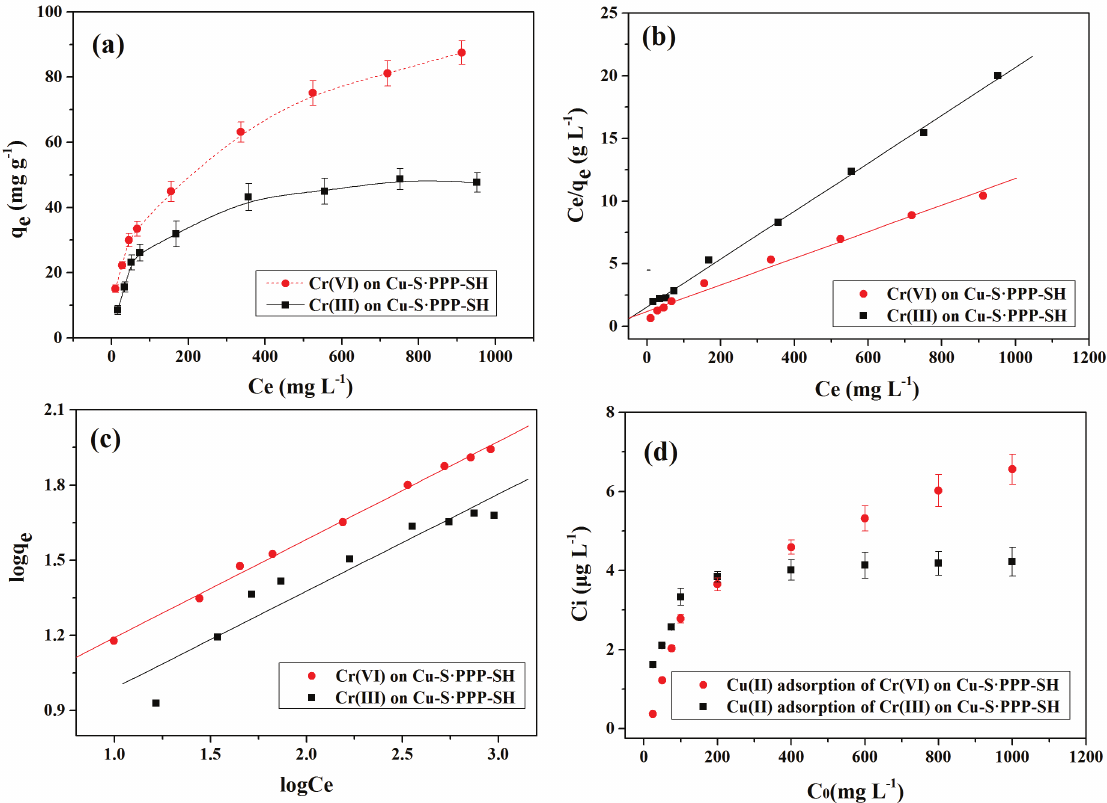
Figure 4: (a) Effect of initial chromium ion concentration on adsorption of Cr(III) and Cr(VI) by Cu-S·PPP-SH; (b) Langmuir adsorption isotherm for Cr(III) and Cr(VI); (c) Frendulich adsorption isotherm for Cr(III) and Cr(VI); (d) Variation of concentrations of Cu(II) with initial chromium ion concentration after adsorption in both systems. Conditions: pH 6.1 and 1.9 for Cr(III) and Cr(VI), adsorbent concentrations 2.0 g L -1